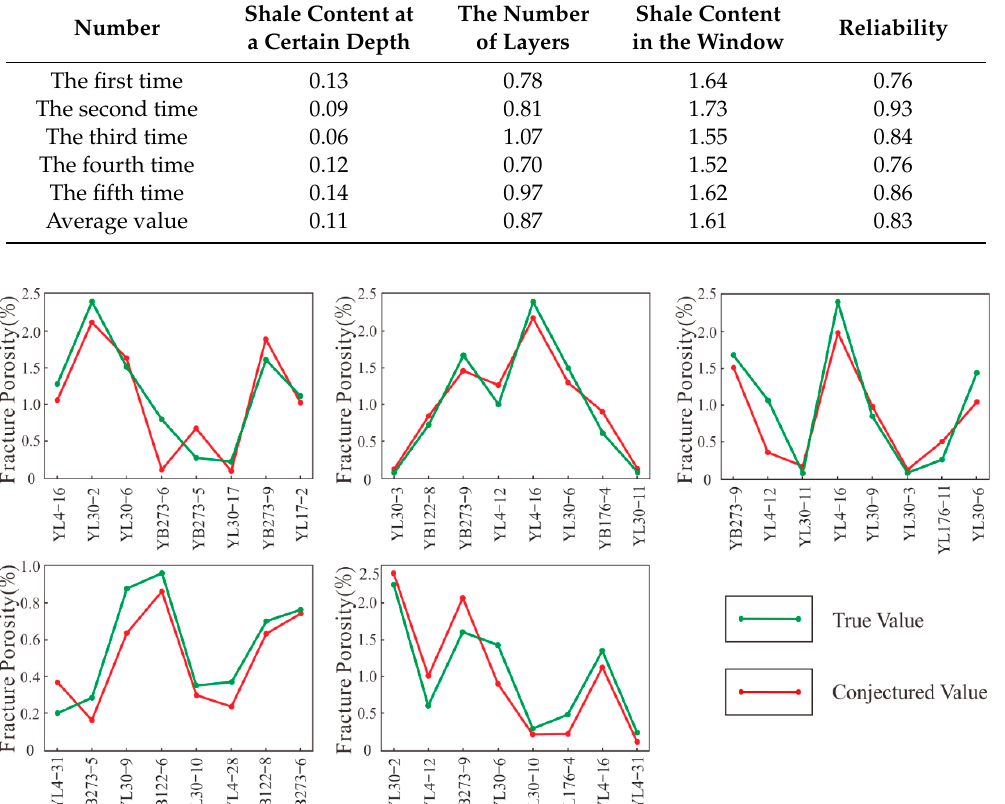
Figure 7. The comparison of the results obtained from learning repetitions with the test set. Five figures represent five verifications (green represents the true value, and red represents the conjectured value).